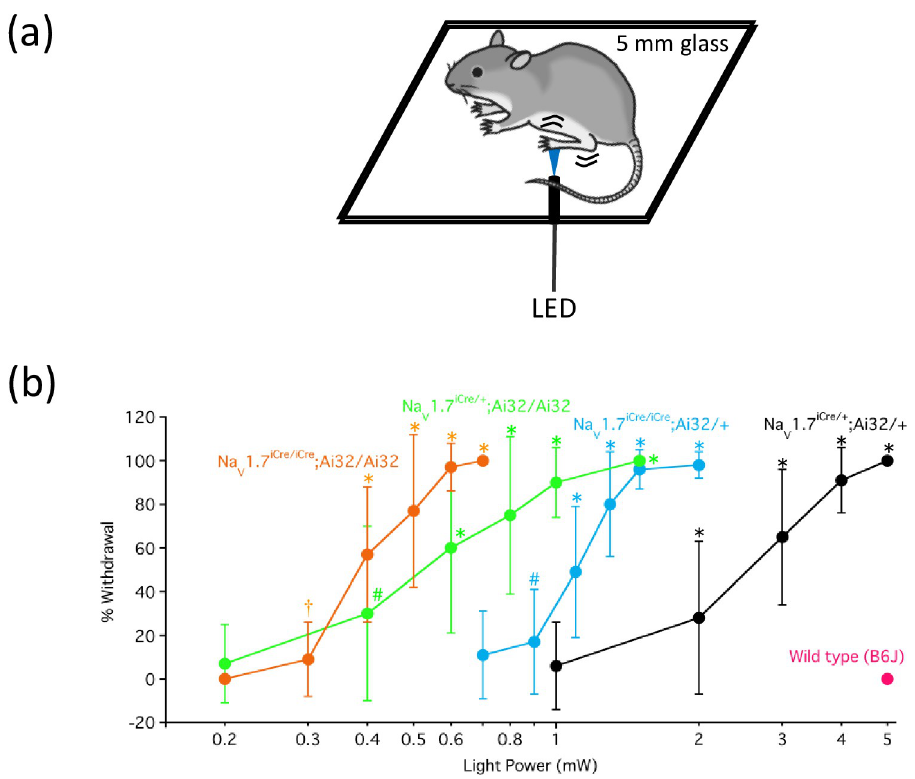
Fig 4. Light irradiation hind paw withdrawal test. (a) Experimental schematic. (b) The blue light irradiation hind paw withdrawal test was performed in wild-type (WT) and mice of the four genotypes. The data were analyzed using one-way ANOVA followed by Bonferroni post-hoc analysis. All results are calculated as mean ± SD of 10 or more animals. � P < 0.001, compared with WT mice. † P = 0.03 and # P = 0.02, compared with WT mice.